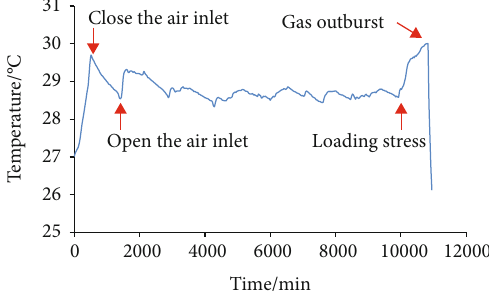
Figure 5: The gas temperature changes in similar materials during the